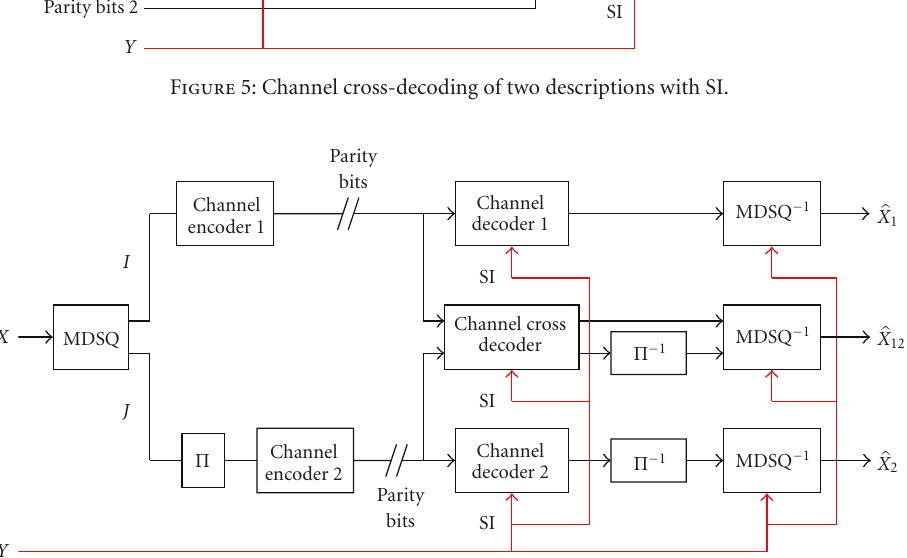
Figure 6: Two-description coding scheme with SI and channel cross-decoding at the central